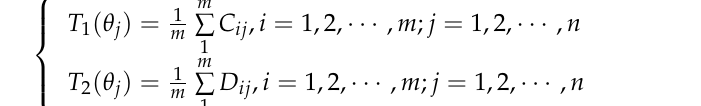
Figure 5. Schematic diagram of Donaldson reversal method measurement: ( a ) before reversal, ( b ) after reversal.